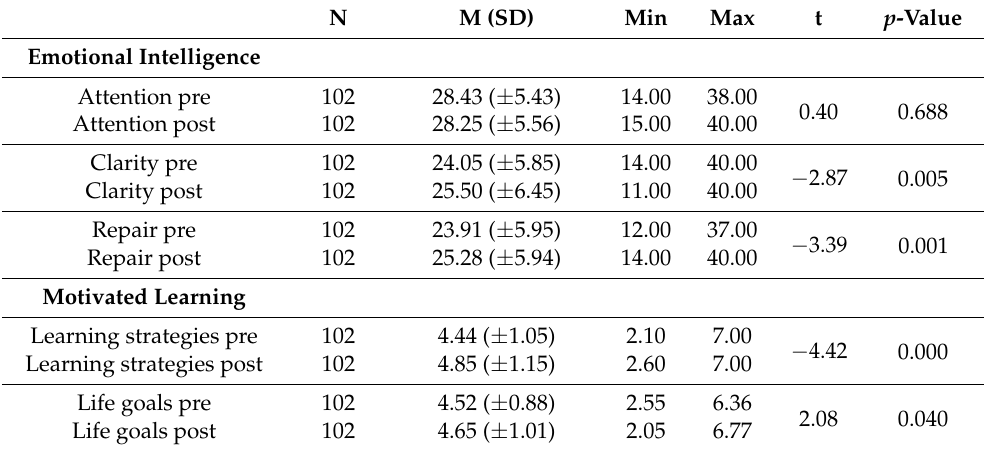
Table 1. Pre- and post-scores for EI, learning strategies, and life goals motivating study of the study subjects. N M (SD) Min Max t p